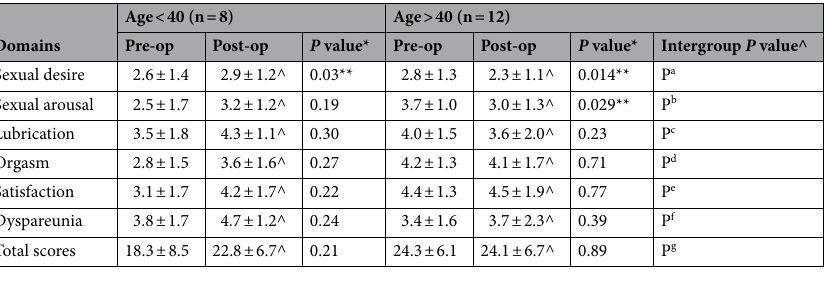
Table 6. Changes in scores of Female Sexual Function Index in both groups before and 6 months after treatment. Data are given as mean ± standard deviation. Pre-op, preoperatively; Post-op, postoperatively. *Paired t -test; ^Student’s t -test; **Statistical significance. P a = 0.72, P b = 0.59, P c = 0.48, P d = 0.13, P e = 0.20, P f = 0.22, P g =